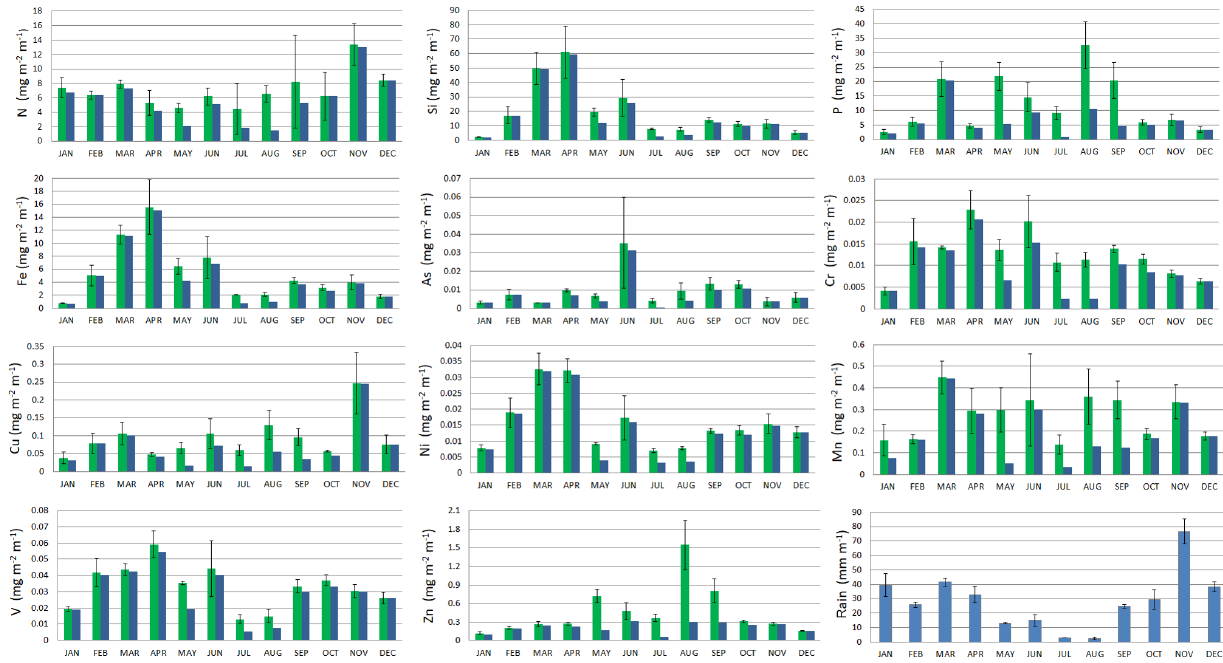
Figure 2. Temporal variation in monthly total (green bars) and wet (blue bars) deposition and precipitation during the sampling period March 2008–October 2011. Bars indicate standard deviations over the weekly values available over the